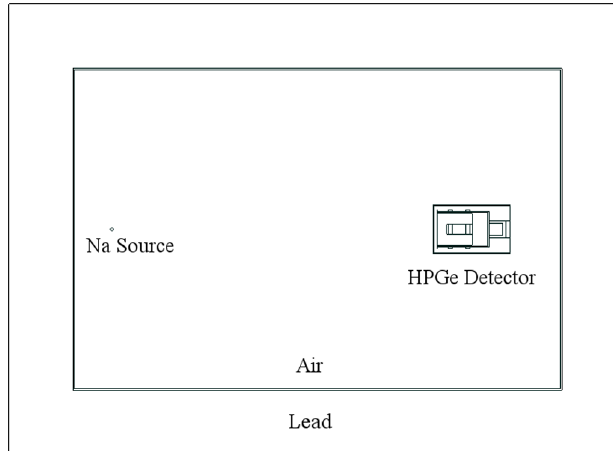
Fig. 8. Gamma spectrometry setting.